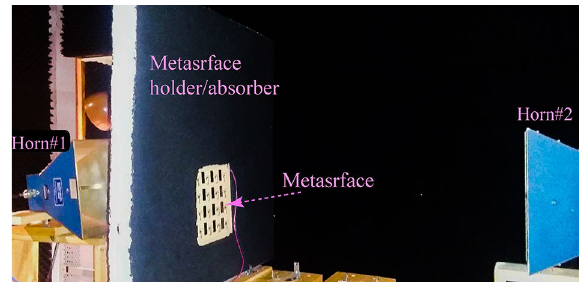
Figure 9. An image of the far-field experimental set-up.